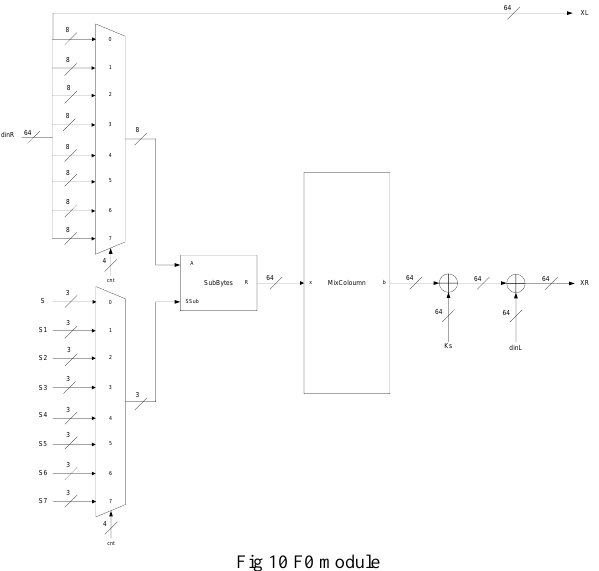
Fig 10 F0 module